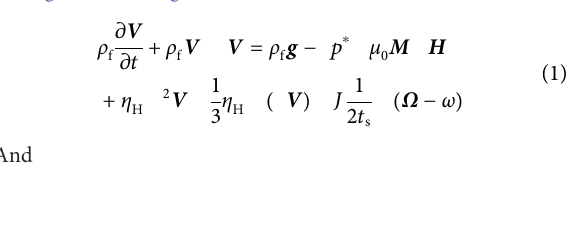
torque will increase, which is not conducive to the dynamic seal; but to a certain extent, the pressure resistance of the static seal will increase.